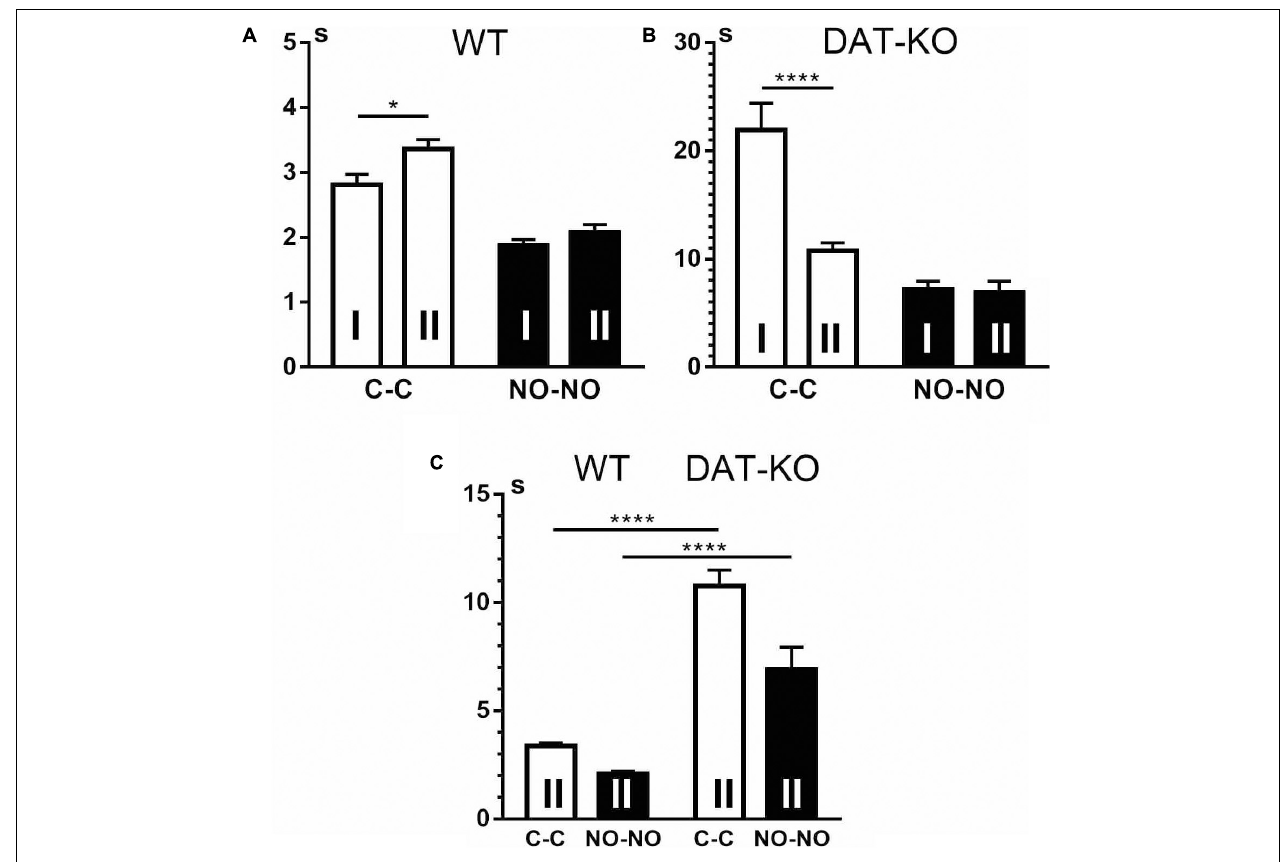
FIGURE 7 | Comparison of the latent periods of running to the first object in WT (A,C) and DAT-KO rats (B,C) in the first (I) and second (II) blocks of experiments. White columns, cube presentation (C-C); black columns, novel object presentation (NO-NO); * p < 0.05; **** p 0 < 0.0001; one-way Kruskal–Wallis test with Dunn’s multiple-comparison post hoc test. WT, wild-type; DAT-KO, dopamine transporter knockout.